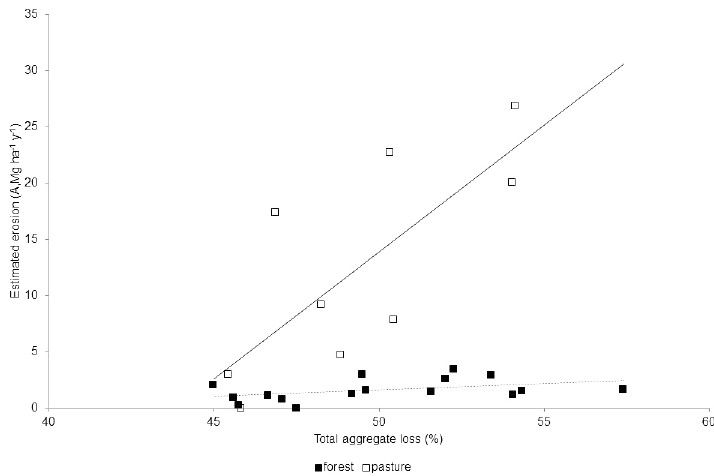
Figure 5. Regression lines between estimated erosion ( A ) and aggregate breakdown for the two vegetation